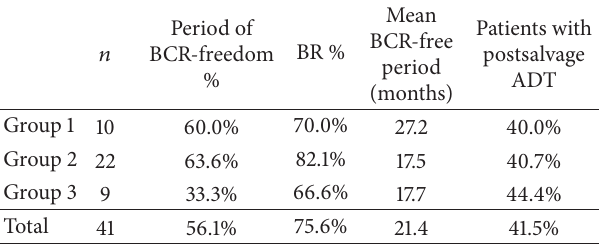
Table 1: Results after salvage treatment in all three groups.